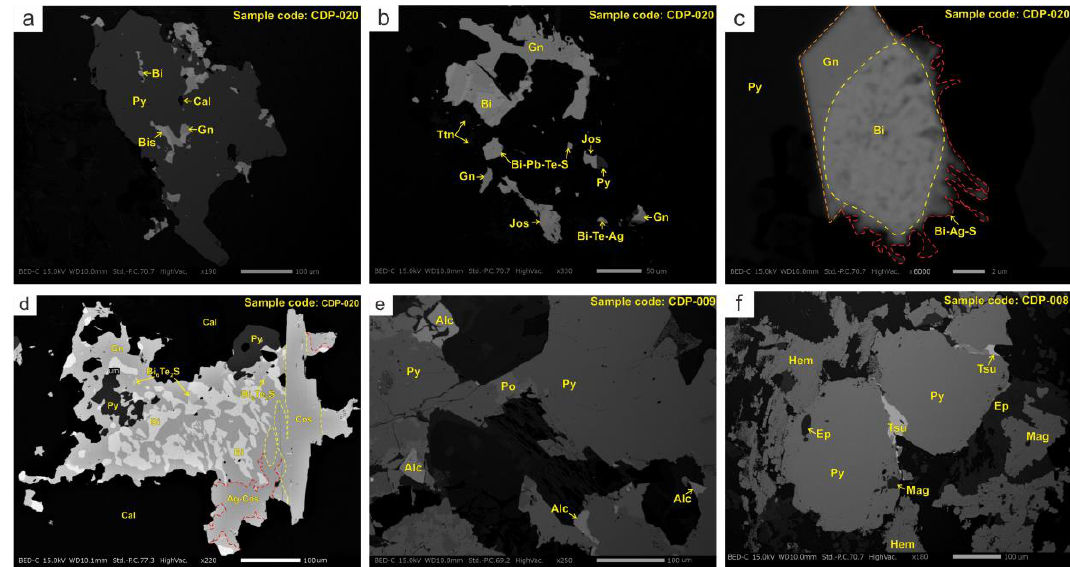
Figure 5. Backscattered electron (BSE) images of Bi-bearing minerals: ( a ) native bismuth and bismuthinite found as inclusion within galena; ( b ) several Bi-bearing mineral assemblages, including native bismuth, Bi-Te-Ag, Joseite-B, and Bi-Pb-Te-S, associated with galena and pyrite; ( c ) complex relationship between galena, native bismuth, and Bi-Ag-S; ( d ) the occurrence of Bi 6 Te 2 S and cossalite associated with galena and pyrite; ( e ) alloclasite typically found as euhedral–subhedral grains associated with pyrite and pyrrhotite; ( f ) tsumoite associated with Fe-mineralization (magnetite–hematite). Abbreviation: Bi: native bismuth; Py: pyrite; Cal: calcite; Gn: galena; Bis: bismuthinite; Ttn: titanite; Jos: Joseite-B; Alc: alloclasite; Mag: magnetite; Hem: hematite: Tsu: tsumoite; Ep: epidote; Cos: cossalite.